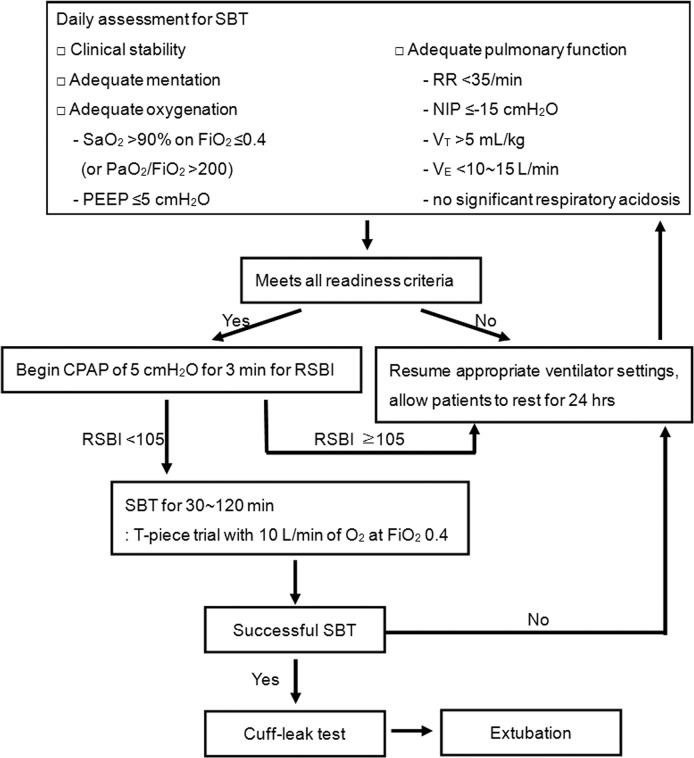
Weaning protocol applied to this study.SBT, spontaneous breath trial; PEEP, positive end expiratory pressure; RR, respiratory rate; NIP, negative inspiratory pressure; VT, tidal volume; VE, minute ventilation; CPAP, continuous positive airway pressure; RSBI, rapid shallow breathing index. * Negative inspiratory pressure (NIP) is the lowest pressure generated during a forceful inspiratory effort against an occluded airway, which is determined by occluding the ventilator’s inspiratory port at the end of expiration for 20 seconds and reading the maximum negative pressure registered on the ventilator’s pressure manometer.